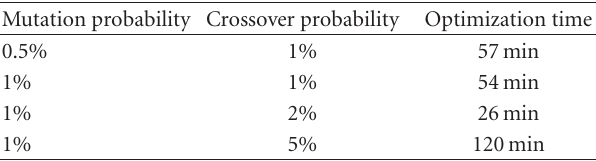
Table 2: Simulation time for GA at di ff erent probability parameters (mutual coupling and conjugate antenna matching).